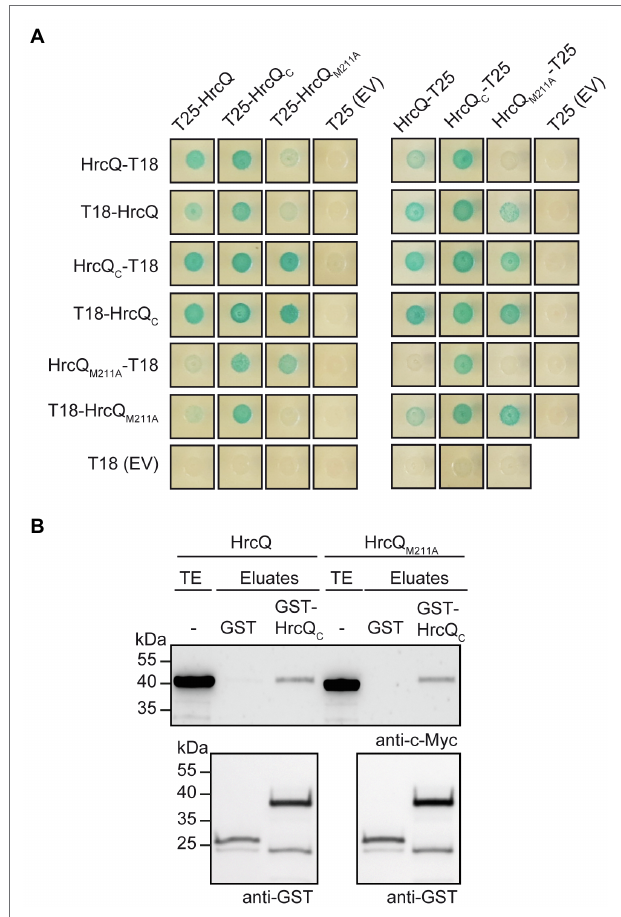
FIGURE 5 | Interaction studies with HrcQ and HrcQ C . (A) In vivo interaction studies with HrcQ derivatives using the BACTH system. Expression constructs encoding T18 and T25 fusions of HrcQ, HrcQ M211A and HrcQ C were cotransformed into E. coli DHM1 cells as indicated. As controls, T18 and T25 fusions were cotransformed with the corresponding empty vectors (EV) encoding T18 or T25. Bacterial cultures were grown on indicator plates and photographs were taken after 3 days. Spots of one representative culture per interaction are shown. Cotransformations were performed three times. Four different transformants for every combination were analyzed in every experiment with similar results. All proteins were stably synthesized as is shown in Supplementary Figure S5 . (B) In vitro interaction studies with HrcQ and HrcQ C . GST and GST-HrcQ C were immobilized on glutathione sepharose and incubated with bacterial lysates containing HrcQ-c-Myc (HrcQ) or HrcQ M211A -c-Myc (HrcQ M211A ) as indicated. Total cell extracts (TE) and eluted proteins (eluates) were analyzed by immunoblotting using c-Myc epitope- and GST-specific antibodies. Experiments were performed three times with similar